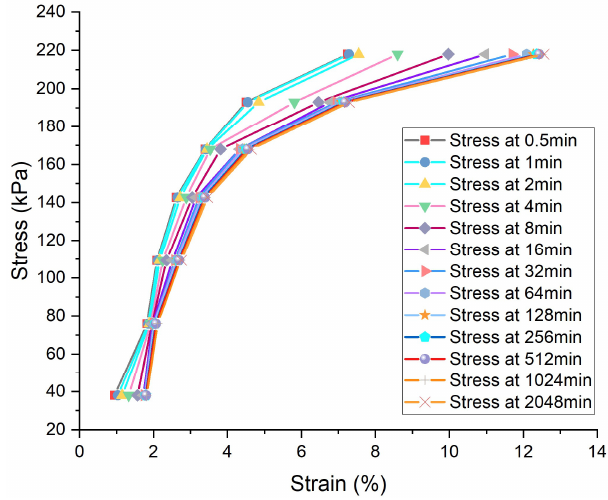
Geotechnics 2022 , 2, FOR PEER REVIEW